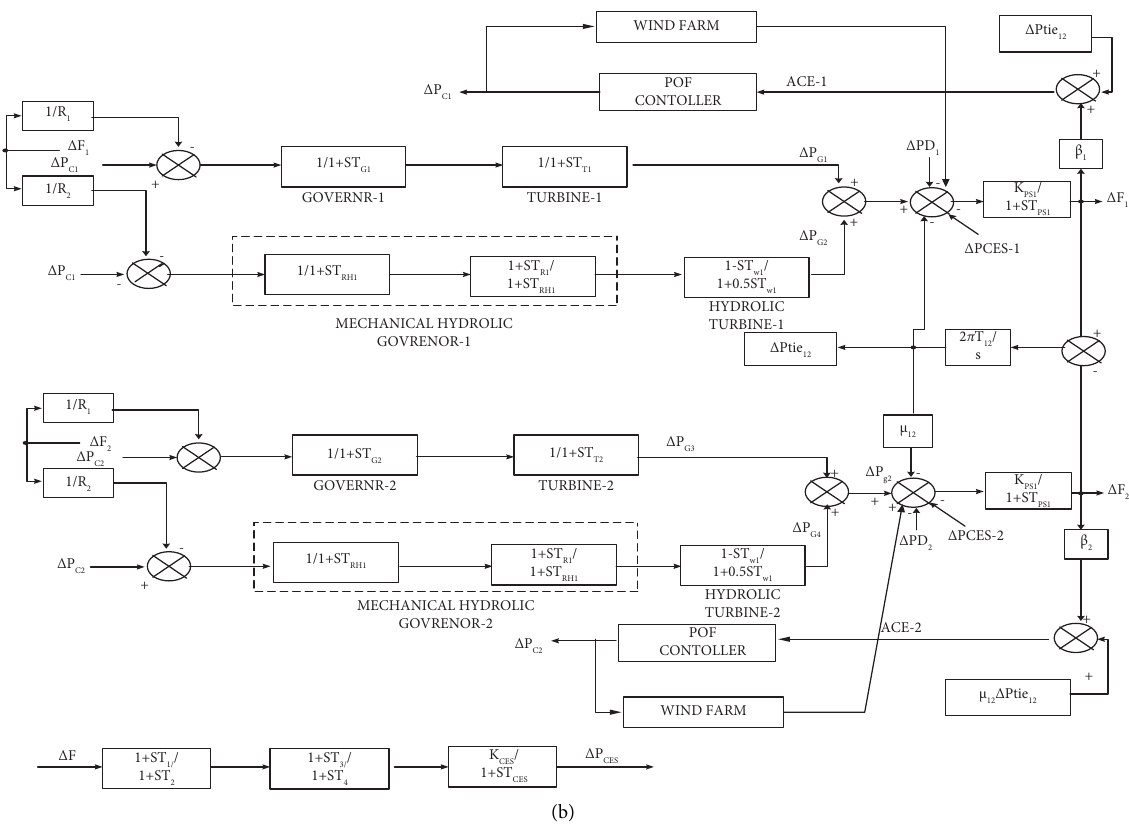
Figure 1: (a) Te two-area, multisource, multiunit hydrothermal LFC test system model. (b) Te two-area, multiunit, multisource wind- integrated hydrothermal power system transfer function